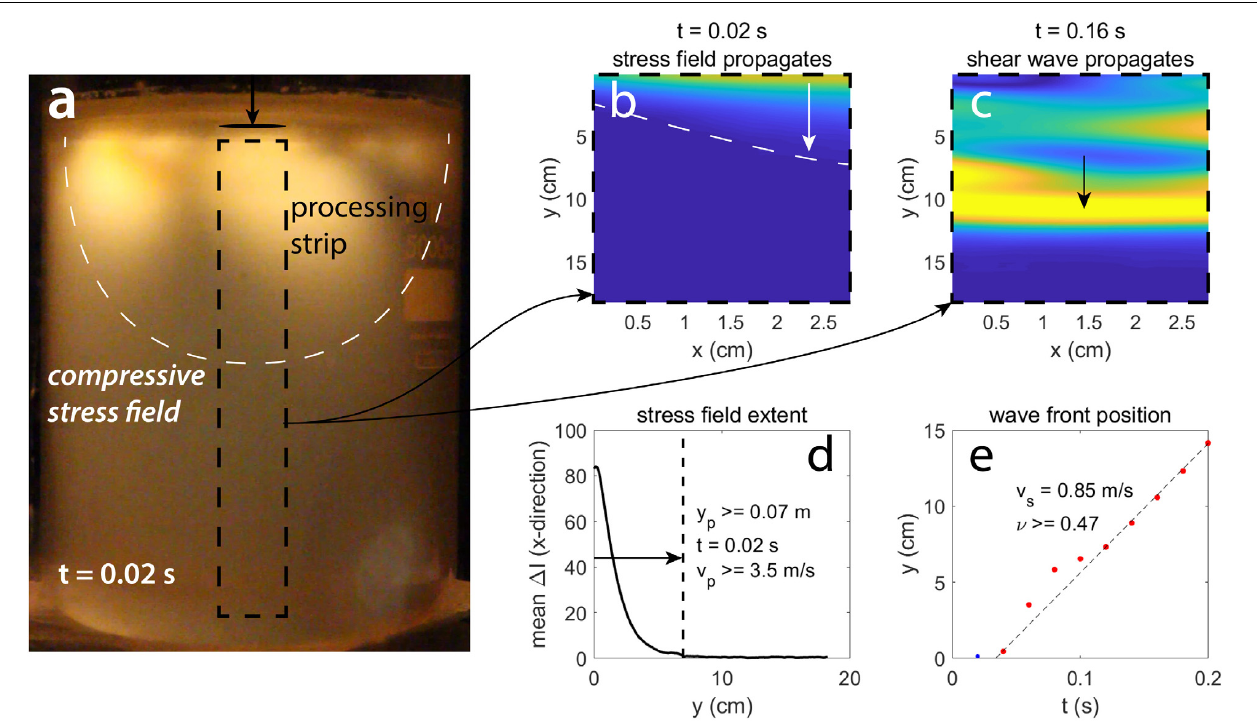
FIGURE 7 | (a) A small gelatin not described in Table 1 , 4 L in volume, 2.7 wt%, E = 2.1 kPa, cooled for 48 h. We dropped a 100 g, 2.5 cm diameter cylindrical mass onto the surface from a short height and recorded how the loading stress propagated. The processing strip illustrated by the black dashed box corresponds to the bounds of subfigures (b,c) . (b) The (cid:49) I of the stress field, in the first frame after dropping the mass. The white line shows the approximate extent of the stress field. (c) The (cid:49) I of the stress field at t = 0.16 s (subtracting the frame for t = 0.14 s), showing the shear wave, which is indicated by the yellow region. (d) The mean (cid:49) I values along the x-direction, showing the approximate extent of the stress field in the y-direction, which is marked by the vertical dashed line. The associated time interval and velocity are indicated. (e) The position of the shear wave front shown against time. The associated velocity is marked by the dashed line and labeled. The Poisson’s ratio is also